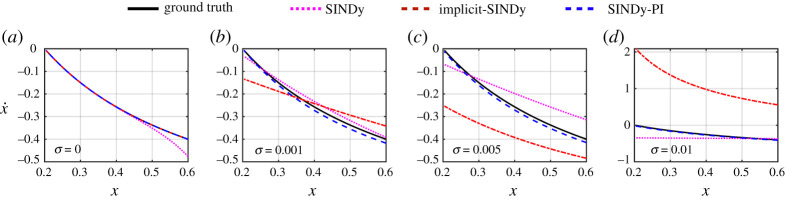
Comparison of the model identified by SINDy, Implicit-SINDy, and SINDy-PI on Michaelis–Menten dynamics. (a) Both SINDy-PI and Implicit-SINDy identified the correct model. However, the SINDy model only agrees for x near the origin. (b–d) As Gaussian noise level increases, the SINDy model degrades further. (Online version in colour.)